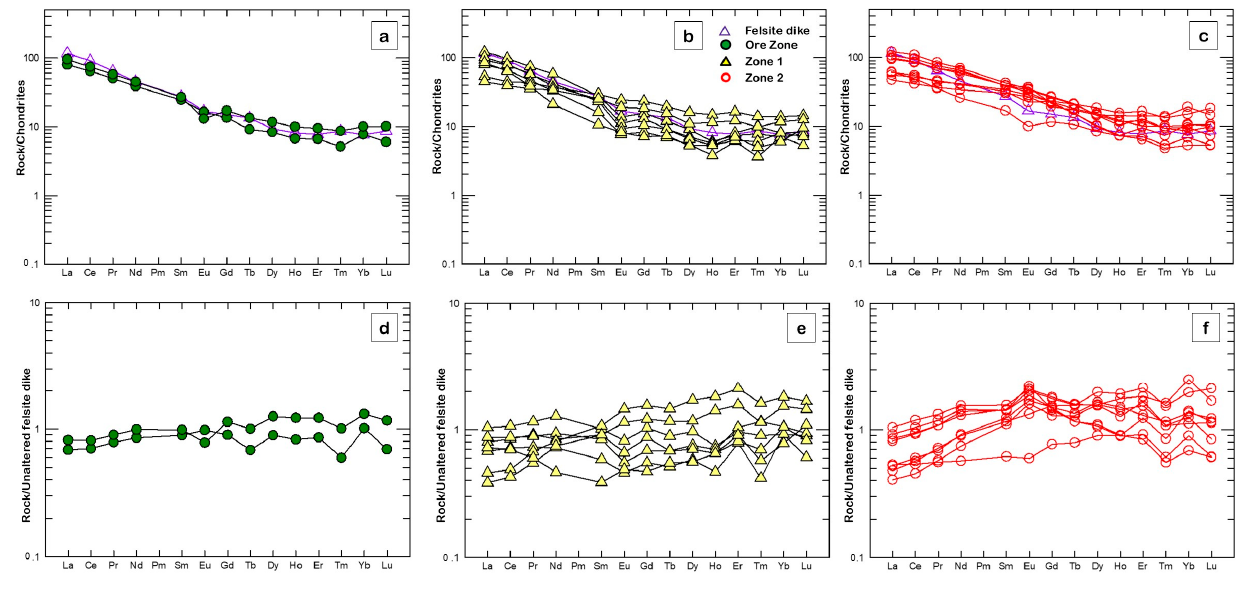
Figure 15. ( a ) REE-Chondrite normalized of ore zone [46]. ( b ) REE-Chondrite normalized of alteration zones-1 [46]. ( c ) REE-Chondrite normalized of alteration zones-2 [46]. ( d ) Chondrite-normalized REE patterns of the ore zone ( e ) Chondrite-normalized REE patterns of the alteration zones-1. ( f ) Chondrite-normalized REE patterns of the alteration zones-2.